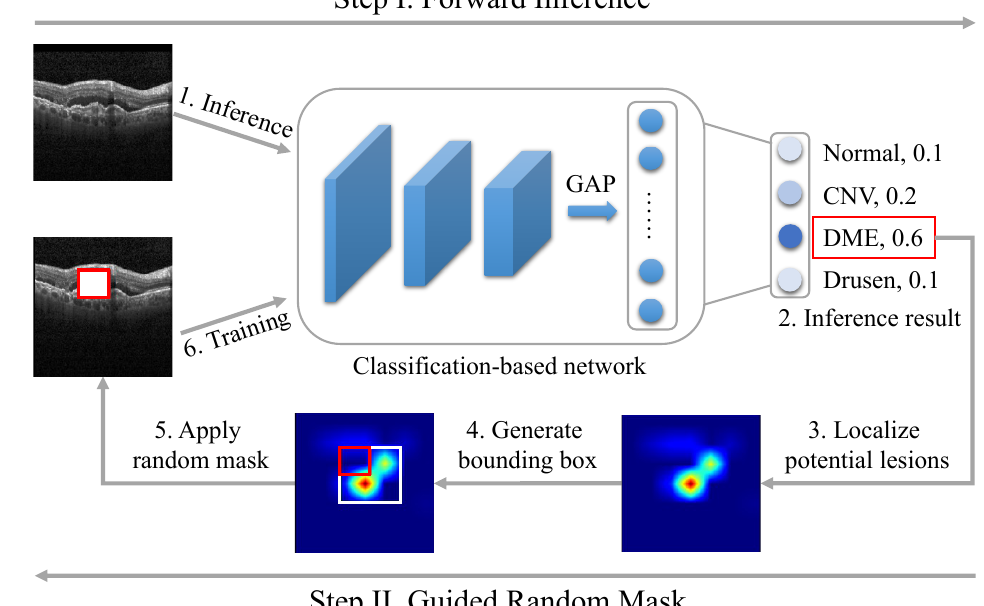
Figure 3. Computation procedures of the proposed GRM method for the classification